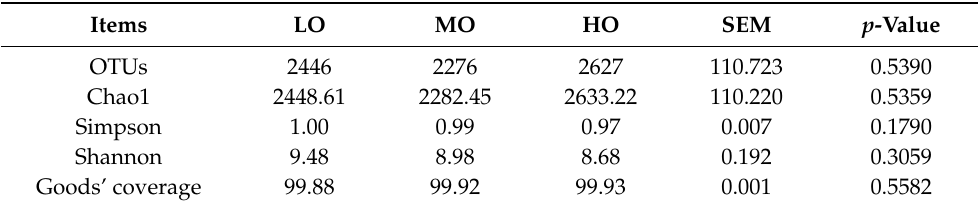
Table 3. Diversity indices of ruminal microbiota of